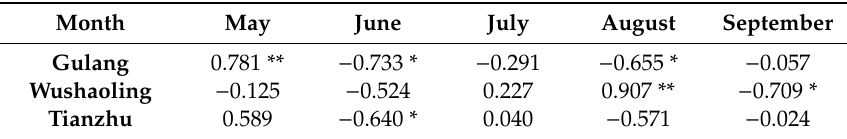
Table 6. Correlation coefficients between soil water δ 18 O and soil water content (SWC). Month May June